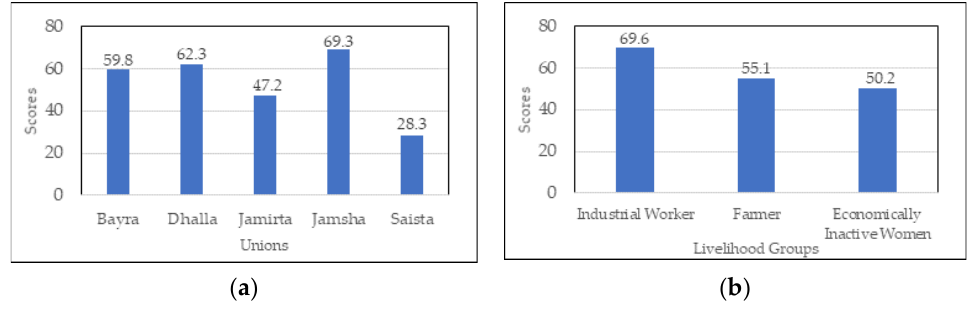
Figure 6. Score of access component for: ( a ) 5 unions; and ( b ) livelihood groups.